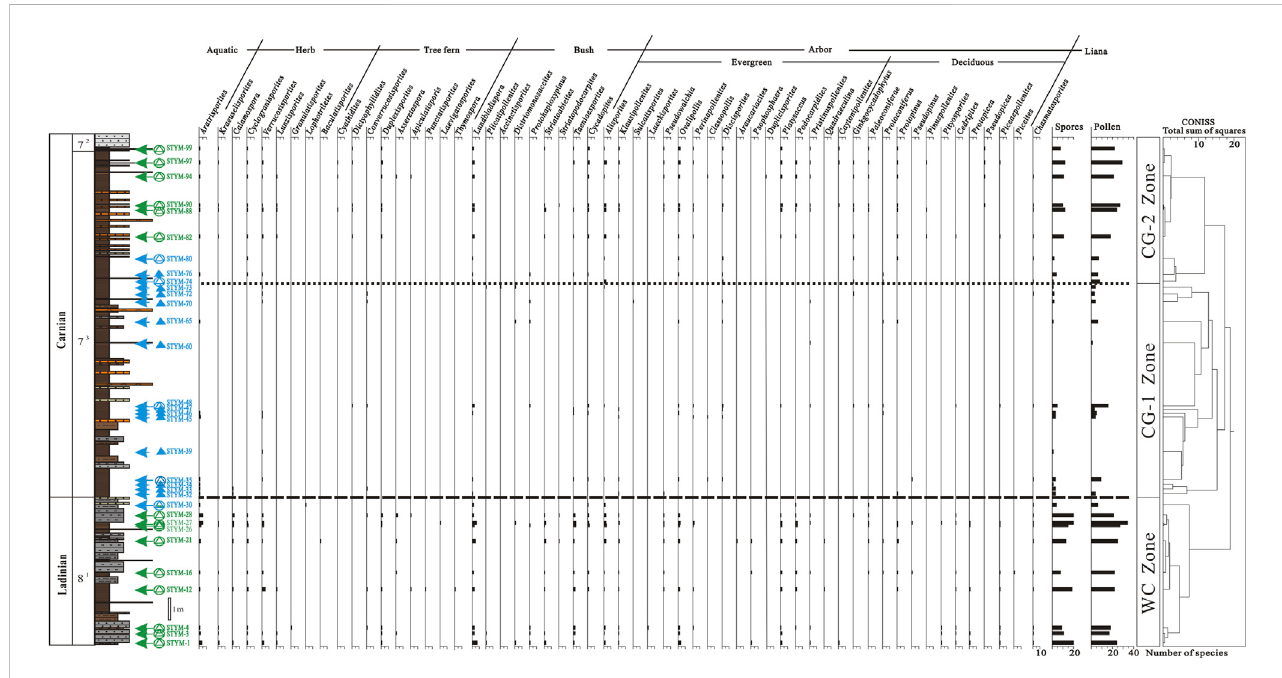
FIGURE 7 Diversity and reconstructed living habit of palyno fl oras at the Yunmeng pro fi le, Ordos Basin,